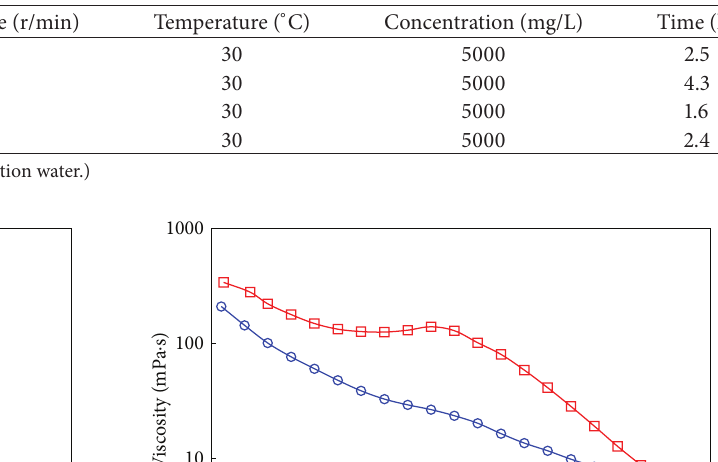
Table 2: The solubility of BHMPAM and HPAM.